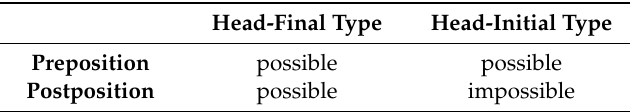
Table 7. Adpositions across language